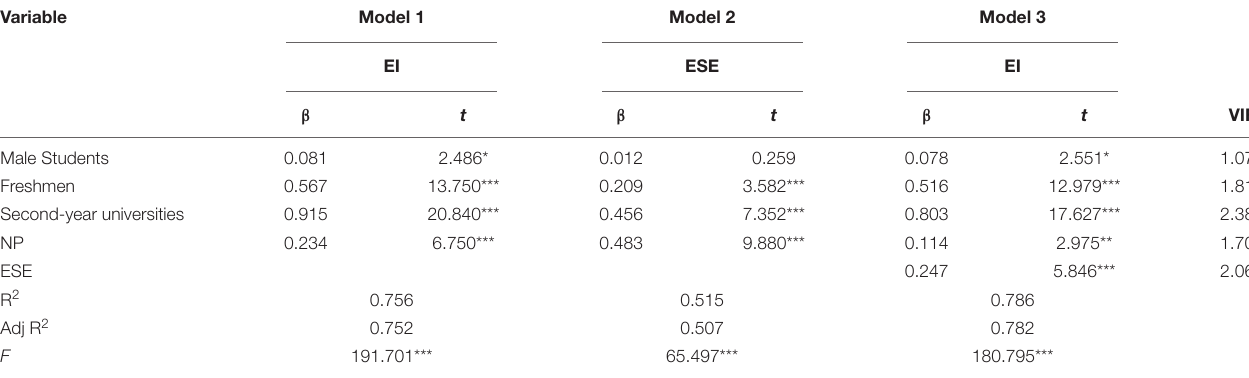
TABLE 2 | Test of the mediation role of entrepreneurial self-efficacy in the effect of narcissistic personality on entrepreneurial intention. Variable